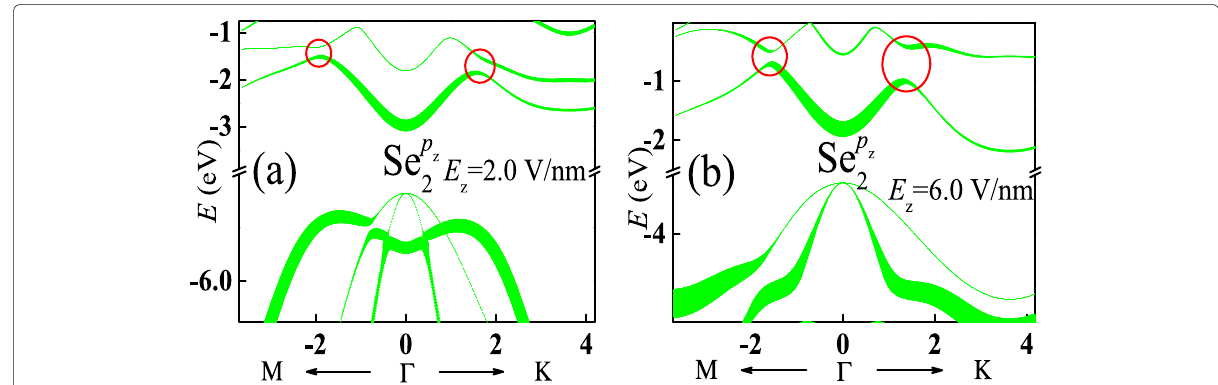
Fig. 4 (Color online) a and b show p z orbital decomposition of the Se ion in sublayer 2 for the energy bands of the monolayer InSe with a perpendicular electric field shown in Fig. 3a and b, respectively. Thicker lines represent a more important